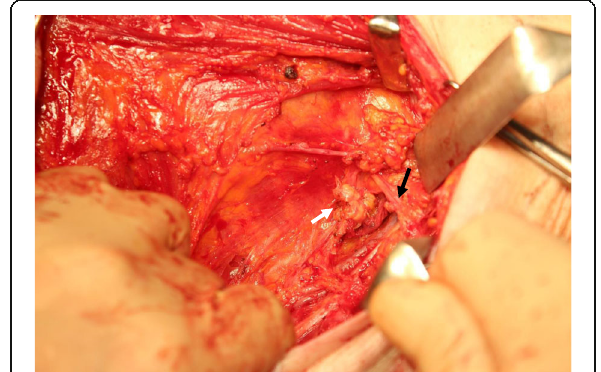
Fig. 3 Operative findings. The white arrow indicates the opening responsible for the chyle leakage; milky fluid flows from the nicked duct